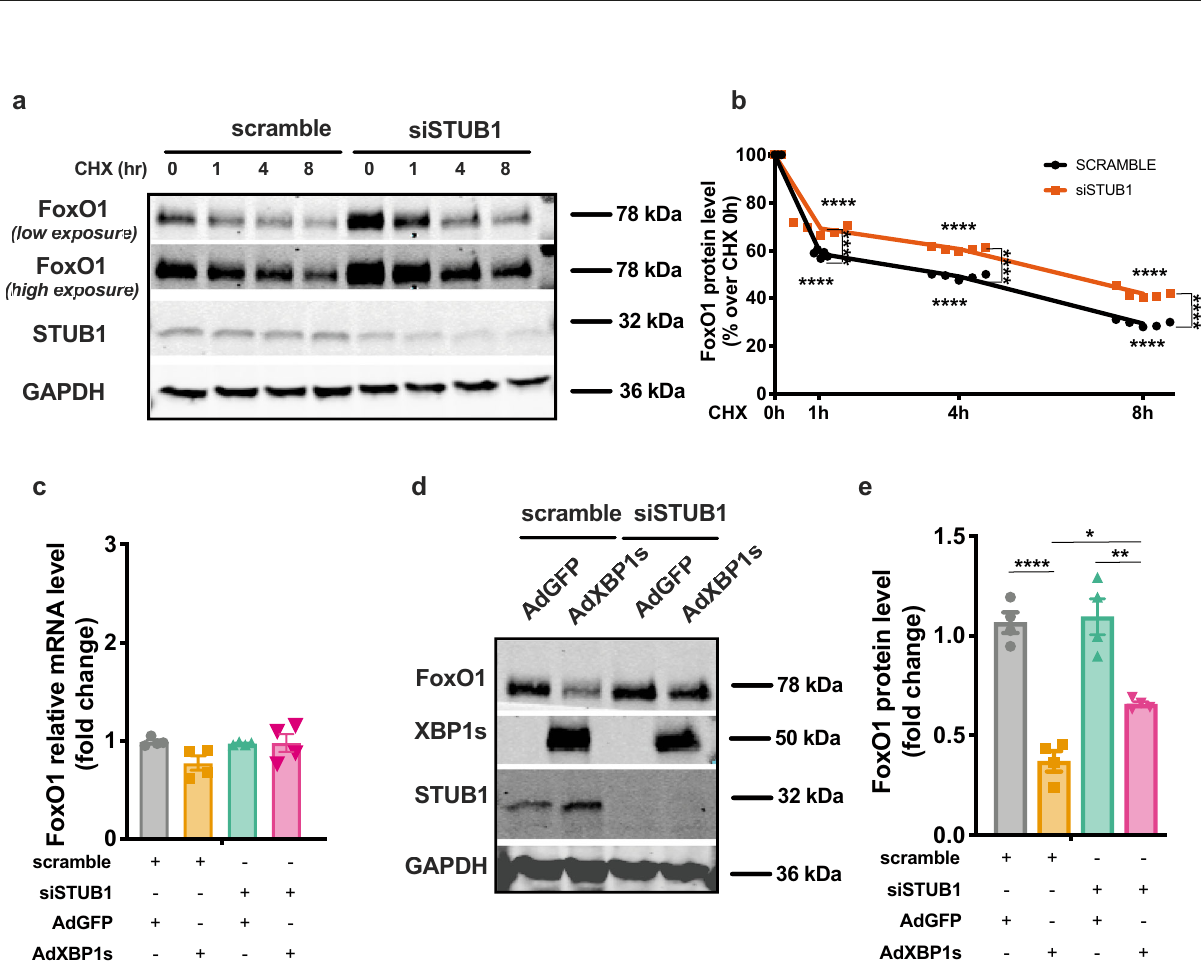
Fig. 5 STUB1 mediates Xbp1s-dependent FoxO1 protein degradation. a Representative immunoblot images of FoxO1, STUB1, and GAPDH proteins from NRVMs transfected with siSTUB1 or scrambled siRNA control and treated with cycloheximide (CHX) for different durations (0, 1, 4, and 8 h). Images are representative of fi ve independent experiments. b Densitometric analysis of FoxO1 protein band in the different experimental groups. ( n = 5 biologically independent experiments). c mRNA level of FoxO1 in NRVMs transfected with siSTUB1 or scrambled siRNA control and transduced with AdGFP or AdXbp1s ( n = 4 biologically independent experiments). d Representative immunoblot images of FoxO1, Xbp1s, STUB1, and GAPDH proteins from NRVMs transfected with siSTUB1 or scrambled siRNA control and transduced with AdGFP, AdXbp1s. Images are representative of four independent experiments. e Densitometric analysis of FoxO1 protein band in the different experimental groups. ( n = 4 biologically independent experiments). Results are presented as mean ± S.E.M. In b , c , and e * p < 0.05, ** p < 0.005, **** p < 0.0001, two-way ANOVA plus Sidak ’ s multiple comparisons test.